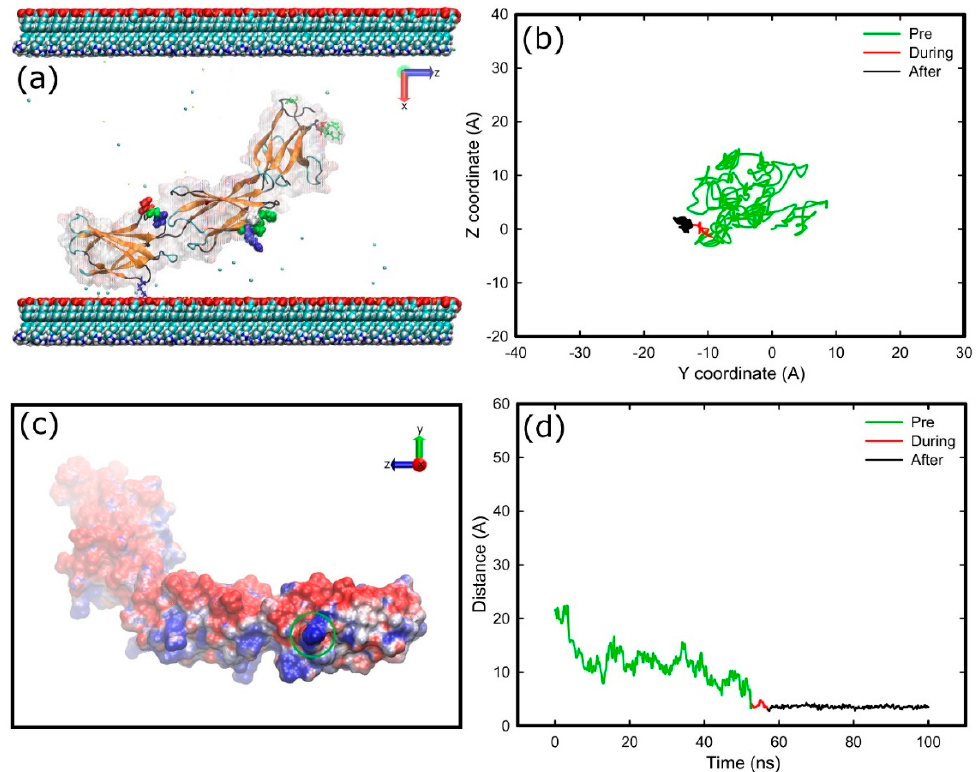
Figure 5. Adsorption of FNIII 8–10 onto carboxyl surface; ( a ) snapshot at the end of simulation, ( b ) diffusion of the anchoring residue over the surface, ( c ) electrostatic representations (APBS) of the FNIII 8–10 fragment as viewed from the carboxyl surface on the final stage of adsorption, and ( d ) distance of the anchoring residue perpendicular to the surface over time. The areas inside the green circles indicate the areas that are in contact with the surface. The deep cueing option of VMD is being used to indicate the distance of each atom from the surface. The colour-coding is the same as previously, while surface atoms and water molecules are not shown for sake of clarity.